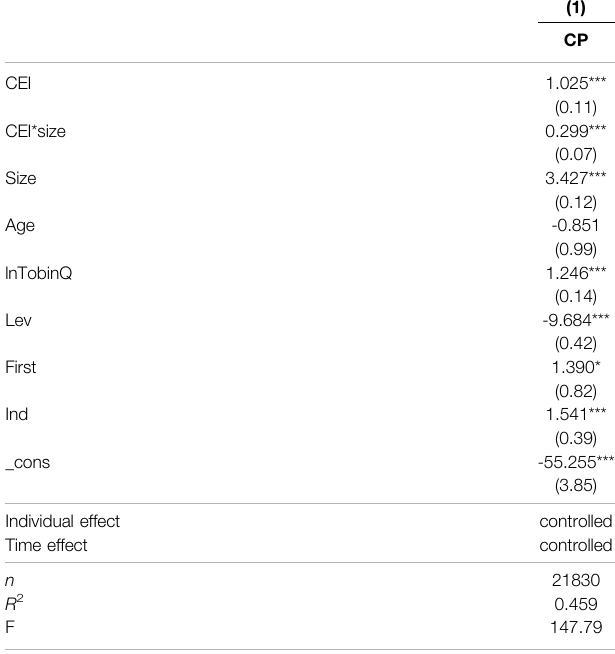
TABLE 10 | Heterogeneity test for corporate